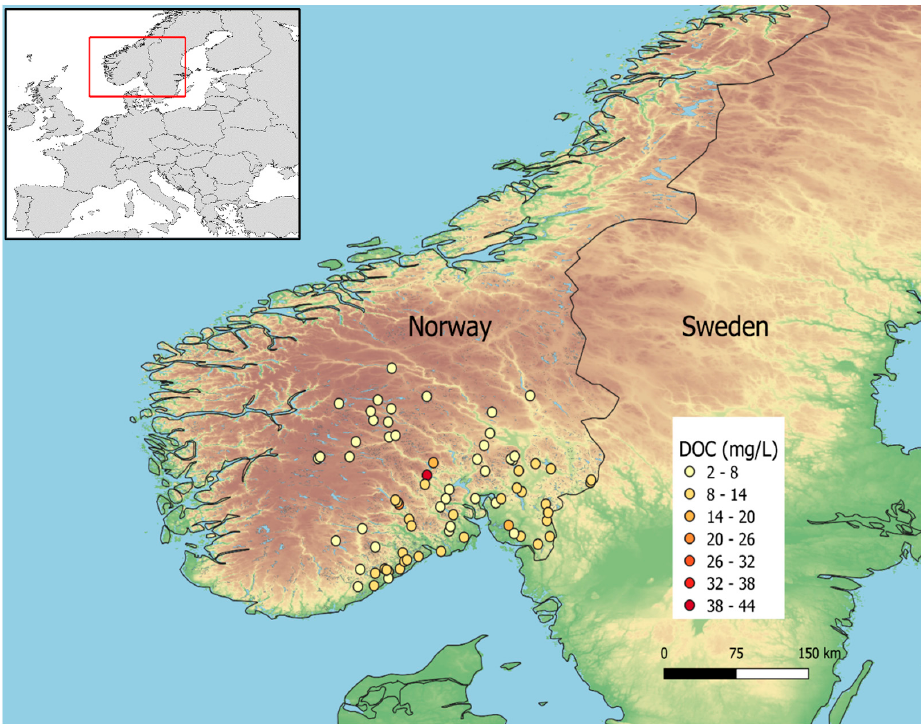
Figure 1. Map of South Norway with the 73 sampled lakes and their DOC concentration (in mg/L) as a proxy for DNOM.